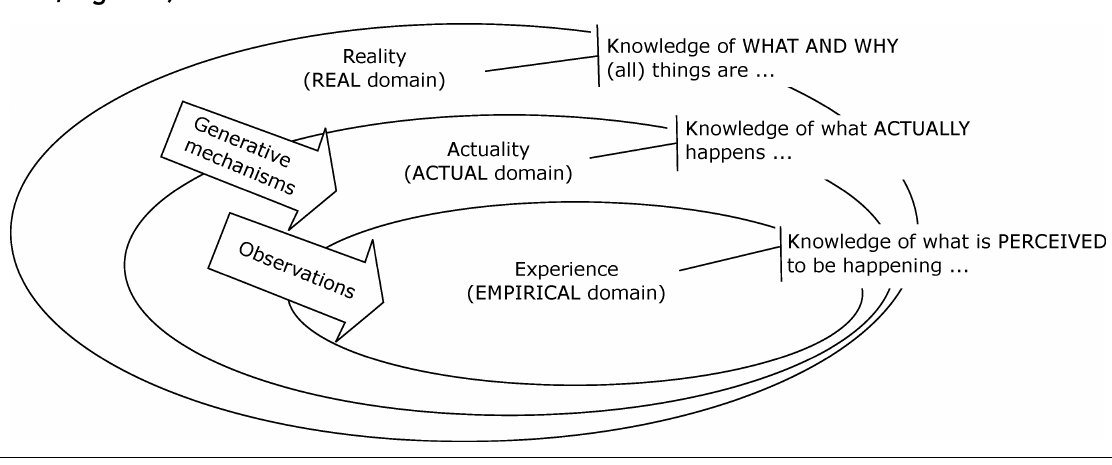
Figure 2. The three domains and three kinds of knowledge proposed by BCR (Source: Bennet, 2013, Figure